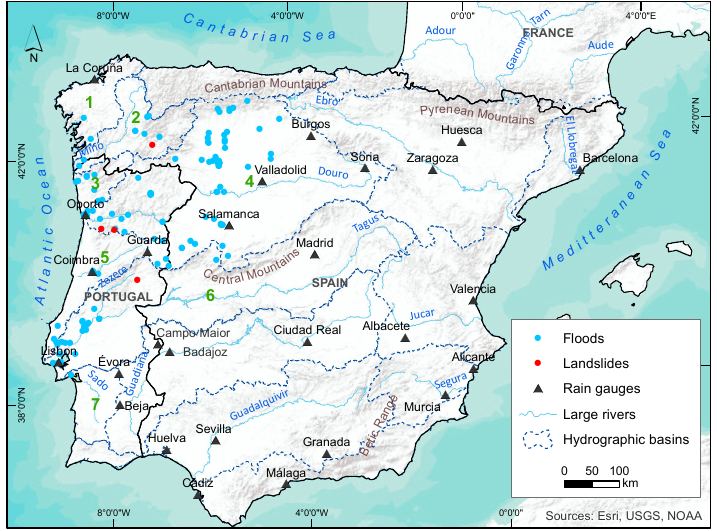
Figure 1. Study area and flood and landslide DISASTER cases from 20–28 December 1909 event over Iberia. Source: Disaster database for Portugal and Spanish newspapers (see Table 1). Numbers in the map correspond to the affected hydrographic basins: (1) Coruña basins; (2) Minho Basin; (3) Lima and Cávado basins; (4) Douro Basin; (5) Águeda, Mondego, and West basins; (6) Tagus Basin; (7) Sado Basin.